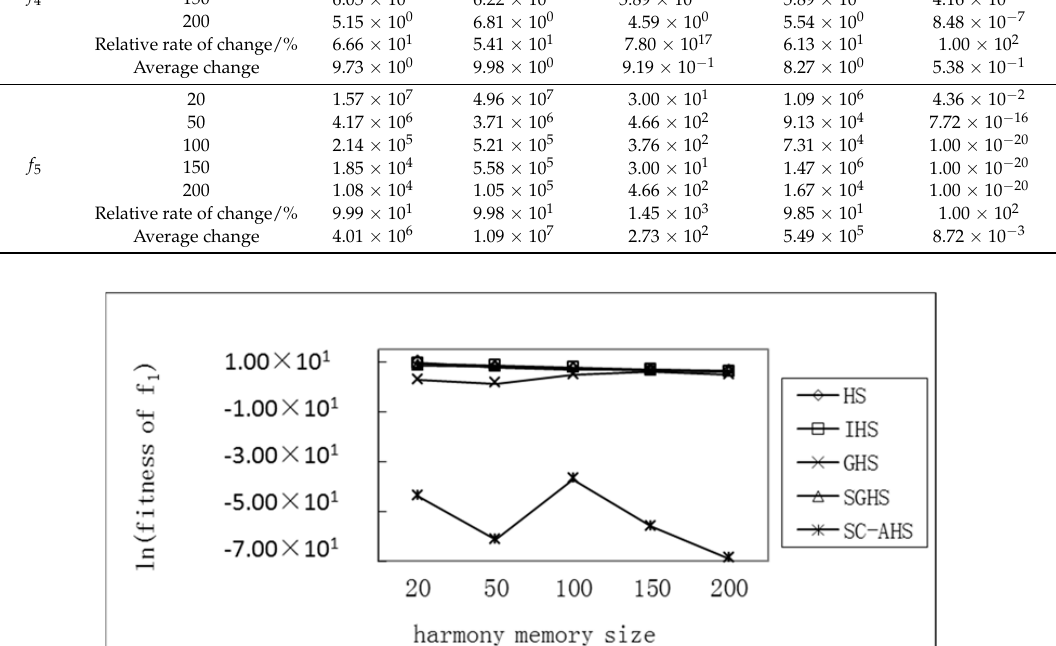
Figure 7. Comparison of the average optimum with different harmony memory sizes of the Sphere function.